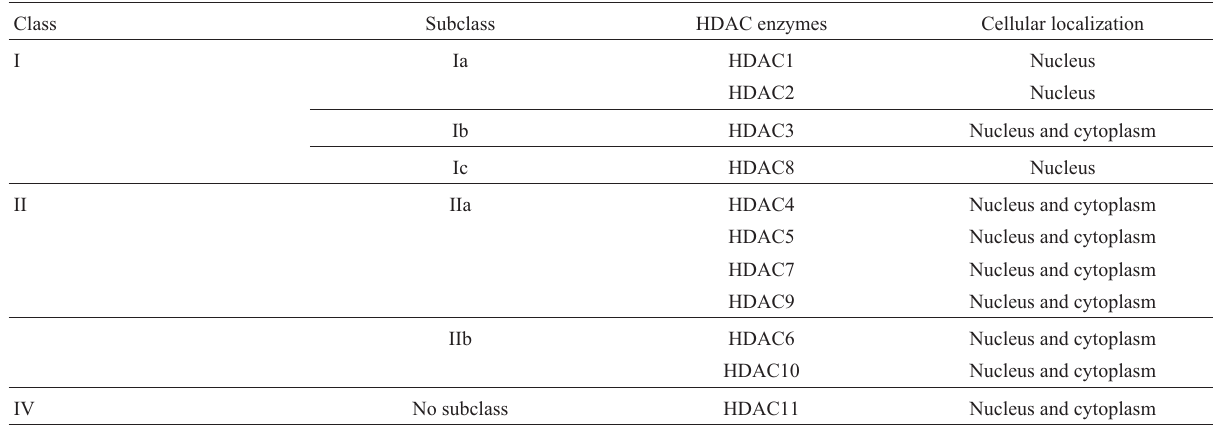
Table 1A - Classification of classic histone deacetylases